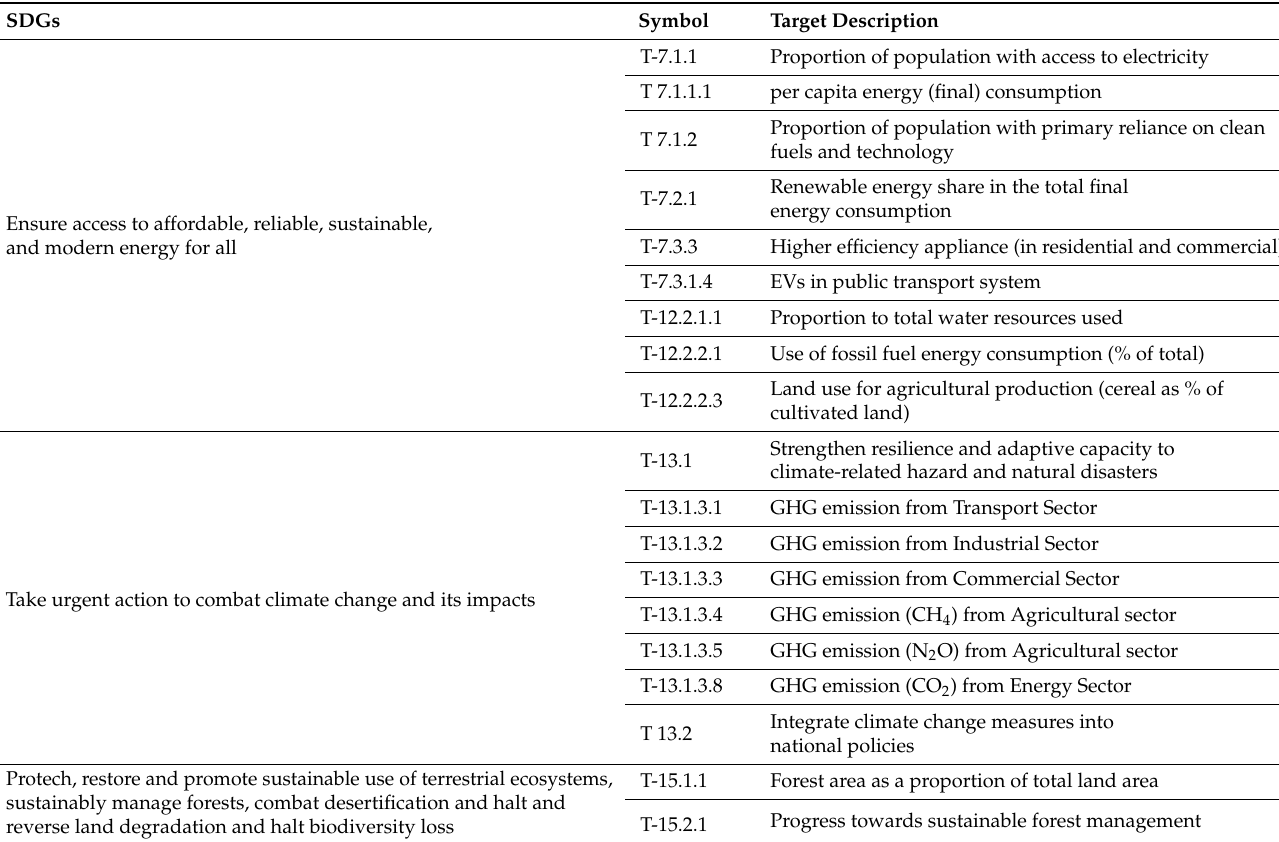
Table 1. Four SDGs examined, their specific targets and indicators [28].